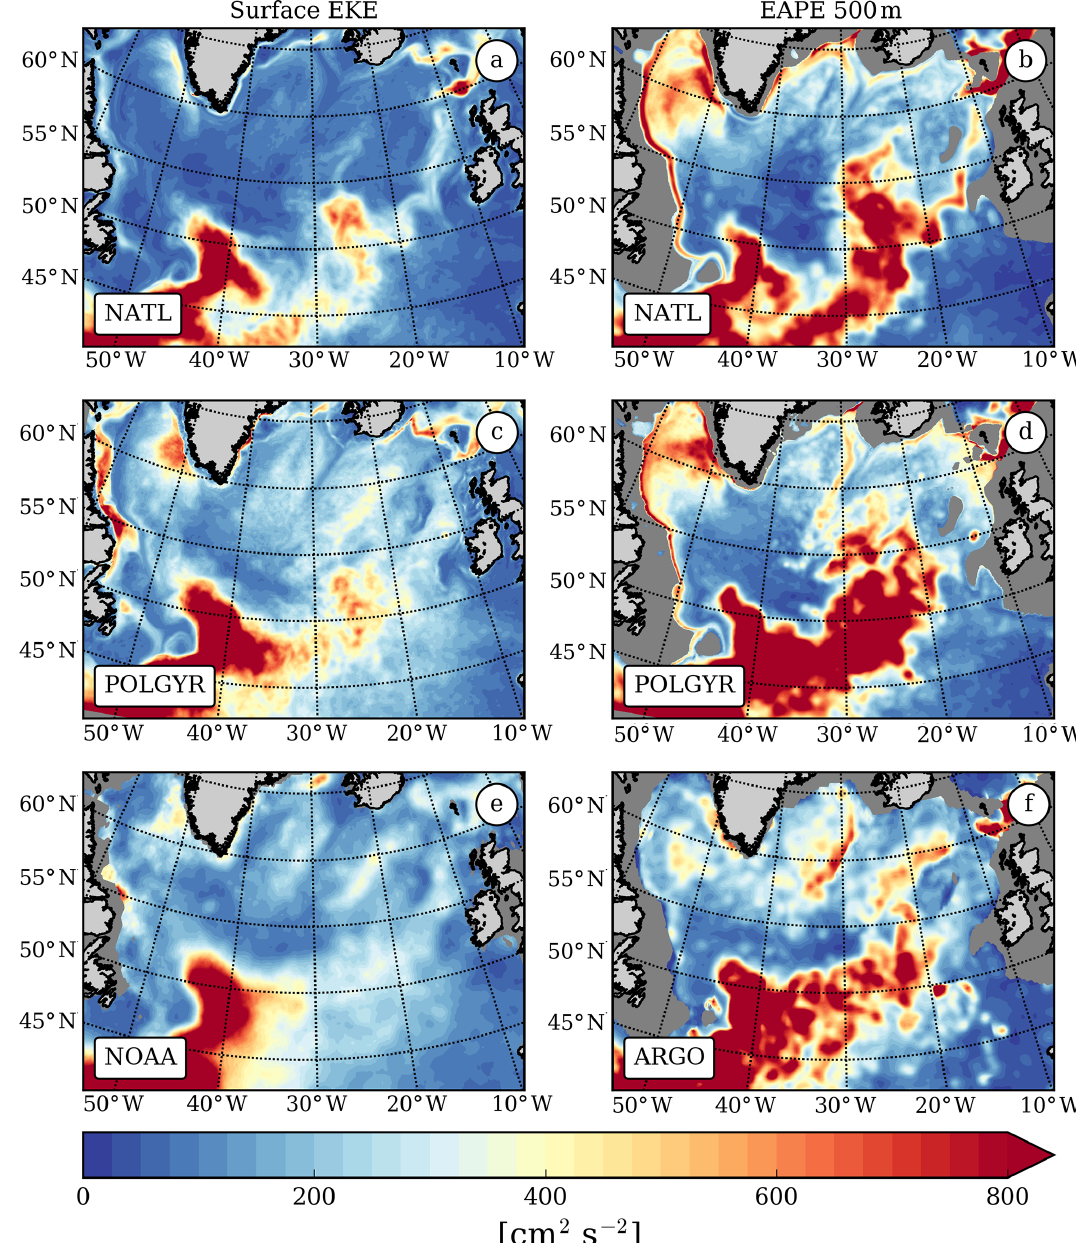
Figure 5. Mean surface eddy kinetic energy (a, c, e) and mean eddy available potential energy between 2002 and 2008 (b, d, f) in NATL (a, b) and POLGYR (c, d) . These are compared with results from the NOAA database (e) and the EAPE atlas from Roullet et al. (2014) (f)